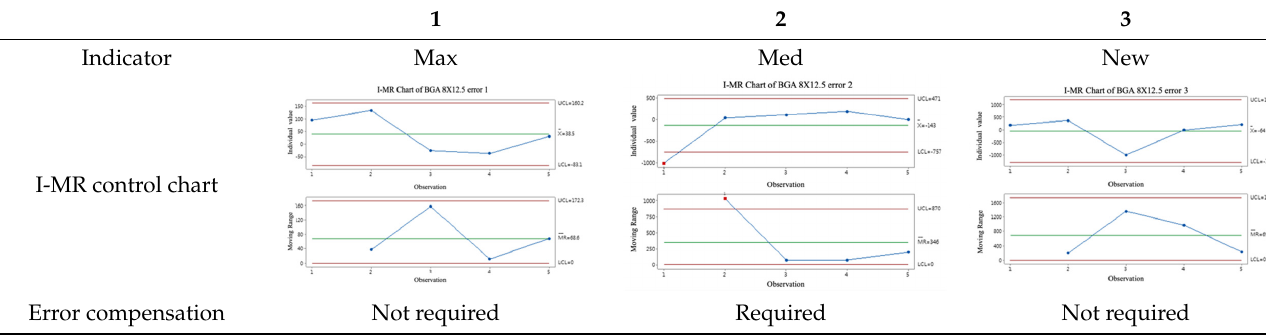
Table 8. BGA 8X12.5 three rolling results.